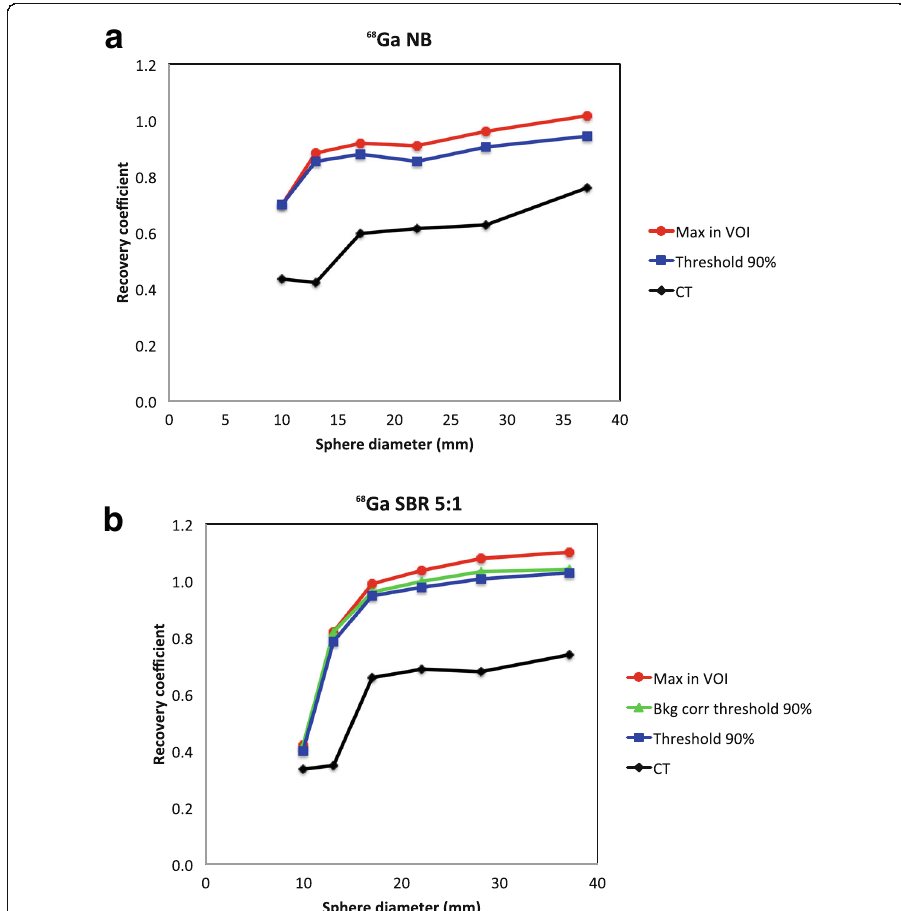
Fig. 3 Recovery curves for the different quantification methods used in this study are shown for 68 Ga-PET with no background activity in the phantom ( a ) and for SBR 5:1 ( b